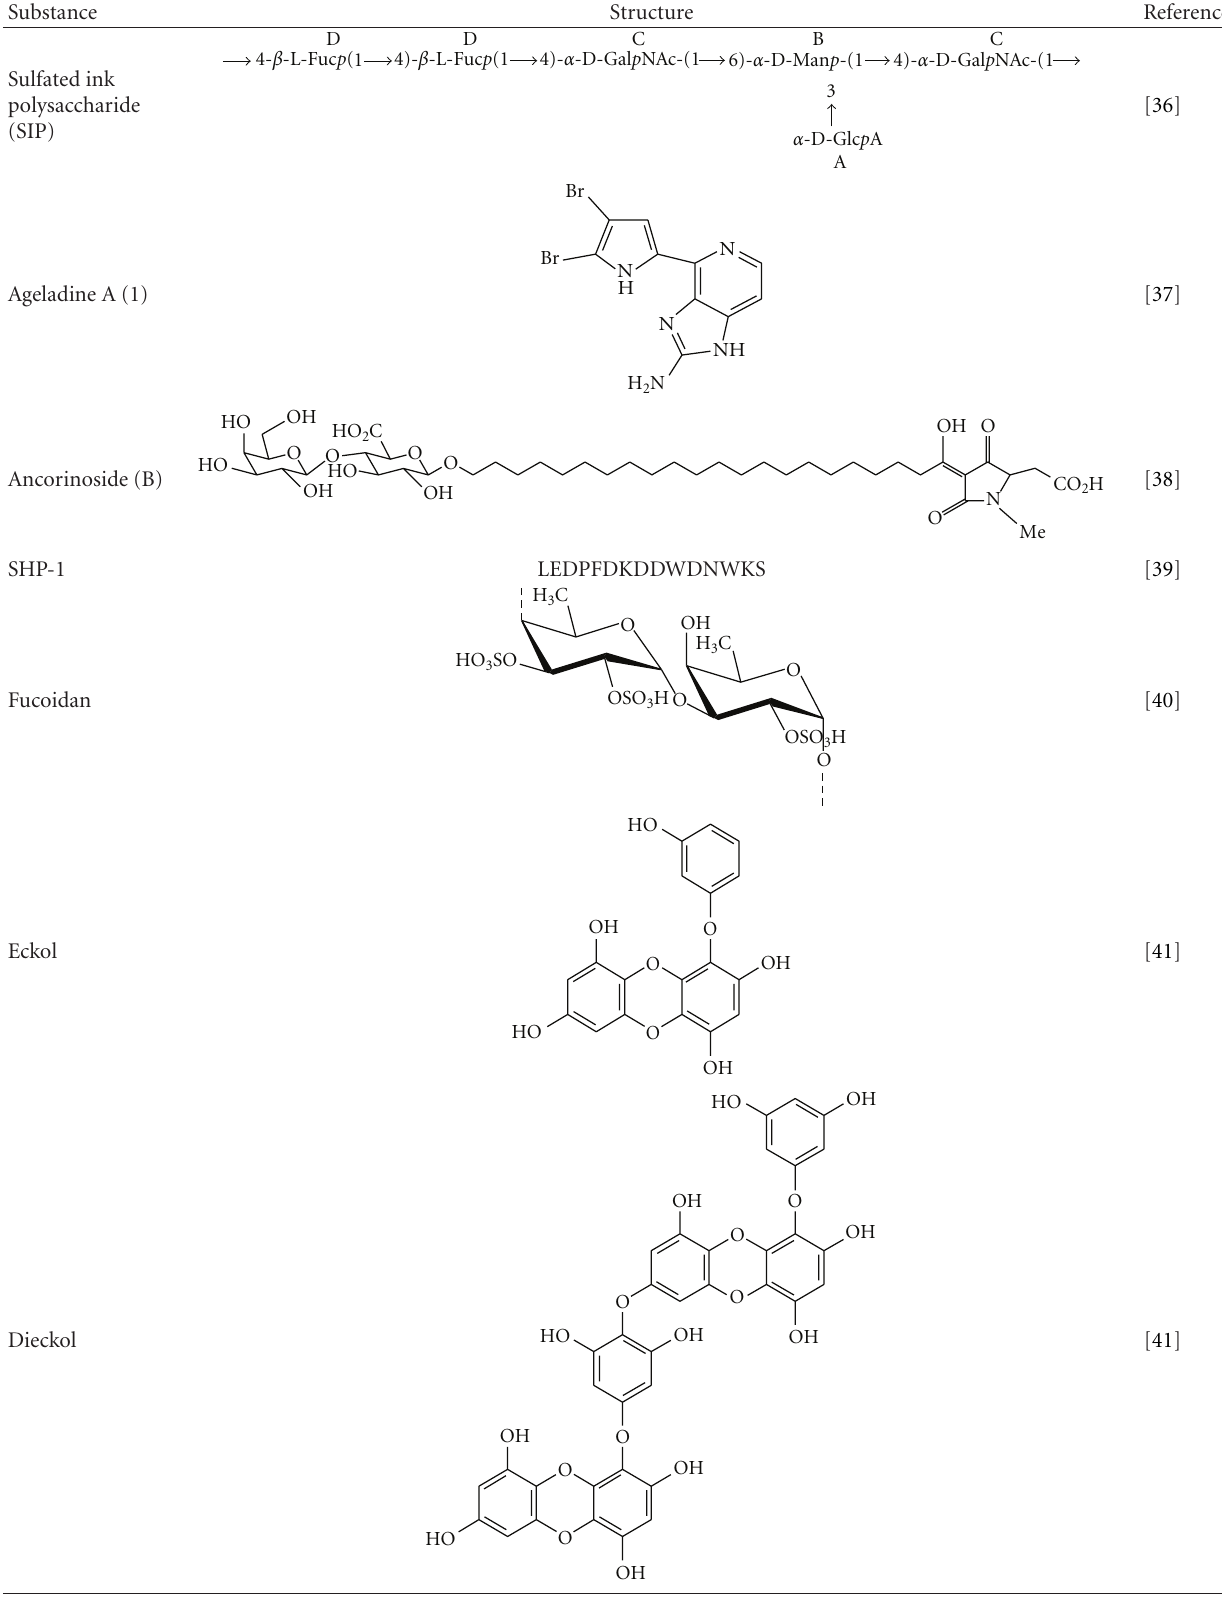
Table 1: List of important substances from marine organisms that inhibit metalloproteinases. Substance